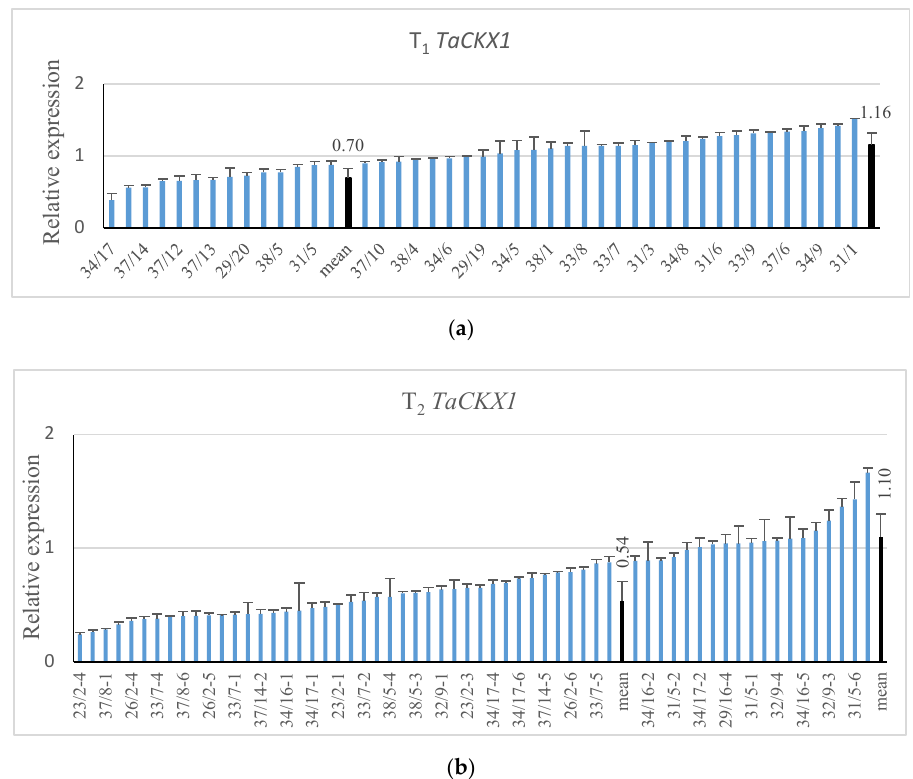
Figure 1. Relative expression level of silenced TaCKX1 in segregating T 1 ( a ) and T 2 ( b ) plants. The level of expression is related to the control set as 1.00.